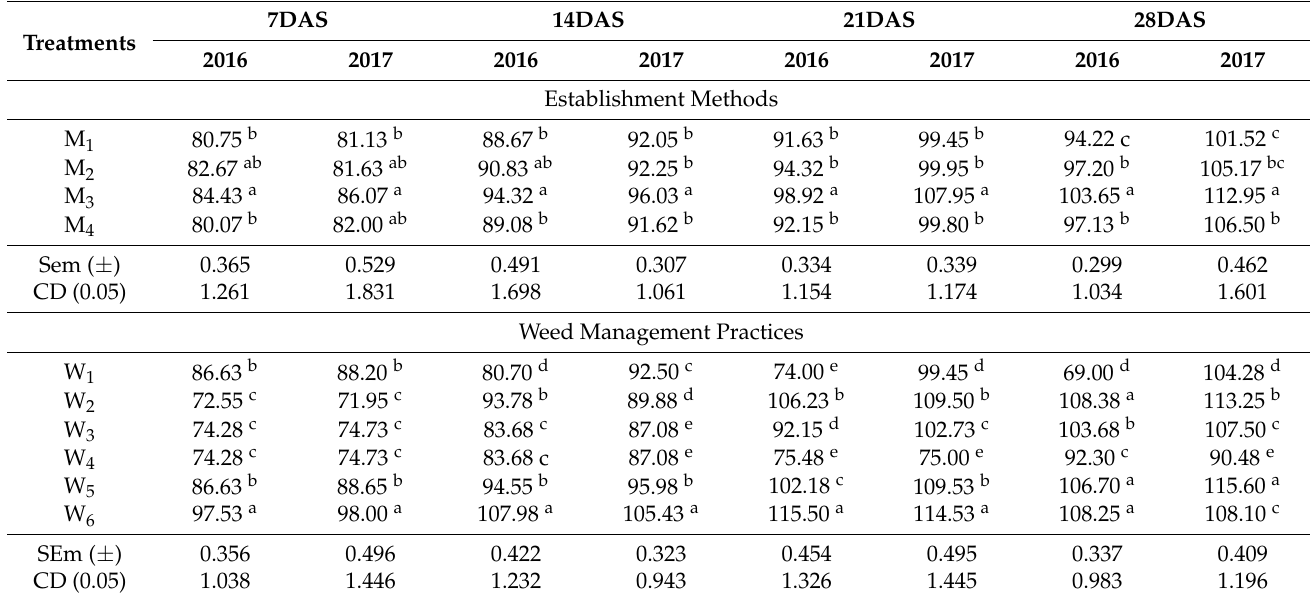
Table 10. The activity of soil enzyme dehydrogenase in rice as influenced by crop establishment methods and weed management practices.